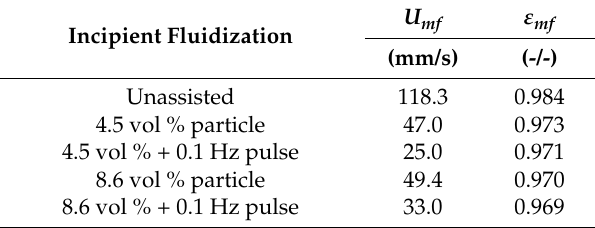
Figure 5. Minimum fluidization calculations for nanoparticle bed fluidization at different assistance conditions. Table 1. Incipient fluidization parameters of the fluidized bed.